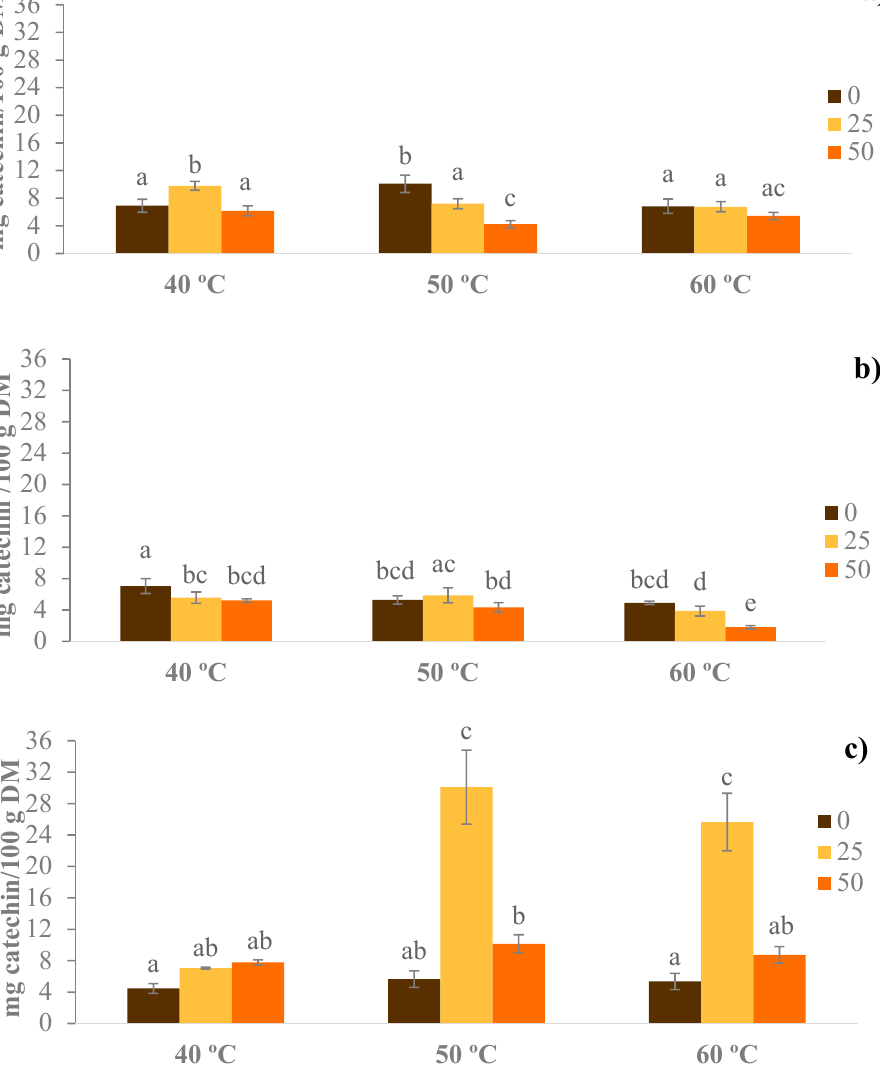
Figure 2. Total flavonoid content, after extraction with different hydroethanolic mixtures (0, 25 and 50% ethanol:water, v / v ), temperature (40, 50 and 60 °C) and extraction time: ( a ) 1 h; ( b ) 2 h; and ( c ) 3 h. Different letters show statistically significant differences ( p < 0.05) for temperatures and concentrations of ethanol used.